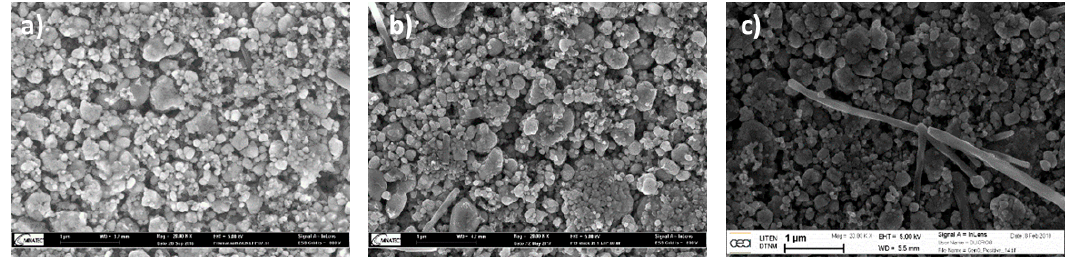
Figure 3. SEM images comparing the morphology of the LFP electrodes taken from ( a ) the fresh cell (after formation), ( b ) Cell A and ( c ) Cell B. All the samples were harvested from the beginning of the stack.